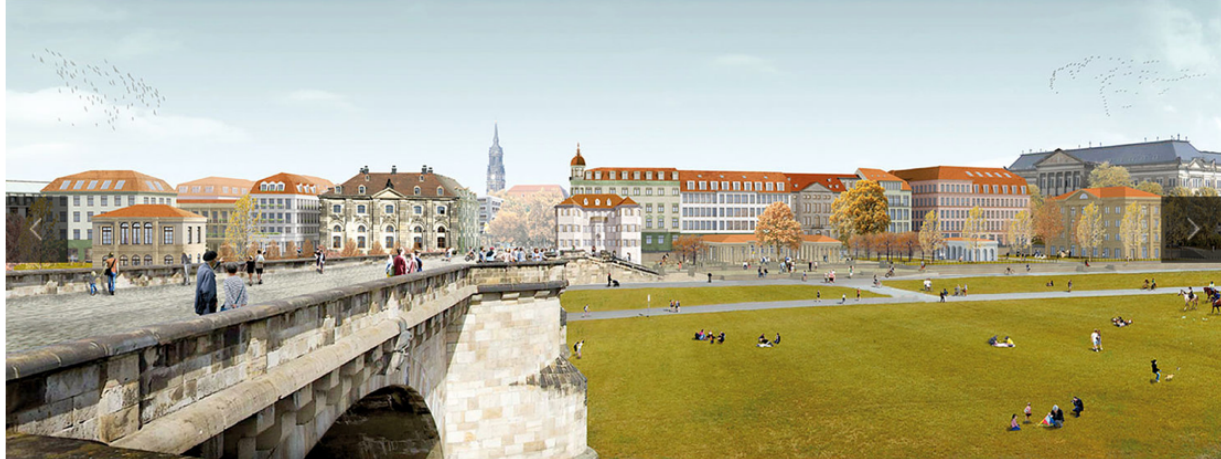
Figure 24. Königsufer and Neustädter Markt , Dresden, Bernd Albers. Perspective from the old city center. Source: Albers (2018).